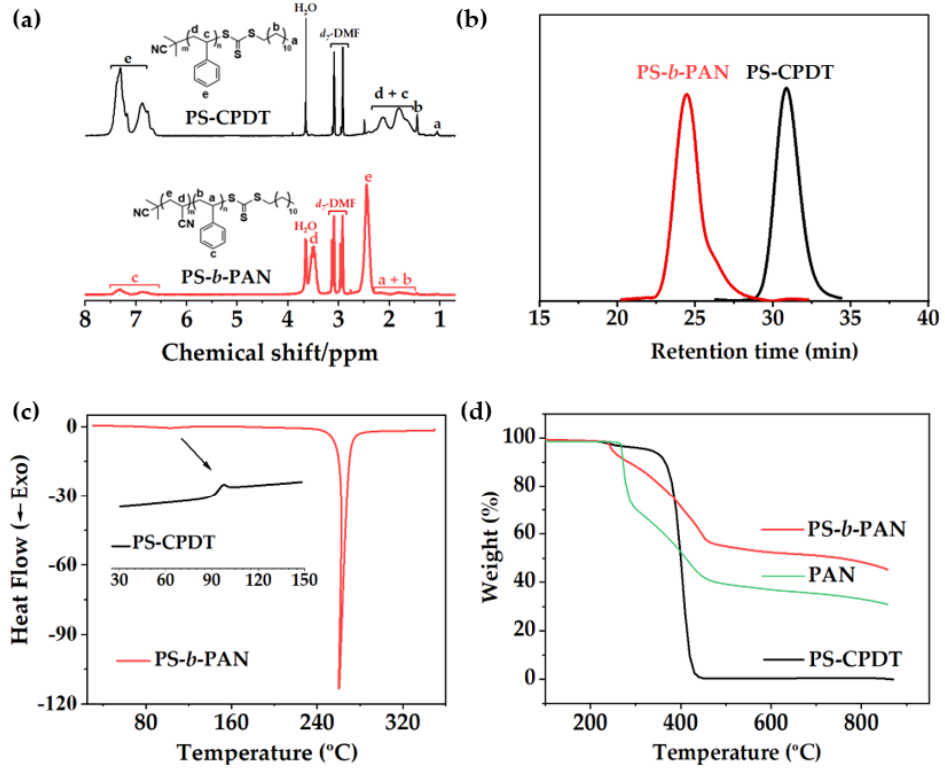
Figure 1. ( a ) 1 H − NMR spectra of PS − CPDT macroCTA (above) and PS − b − PAN polymer (below), ( b ) SEC chromatograms, ( c ) DSC thermograms of PS-CPDT (insert graph) and PS − b − PAN ( d ) TGA curves of PS − CPDT and PS − b − PAN.